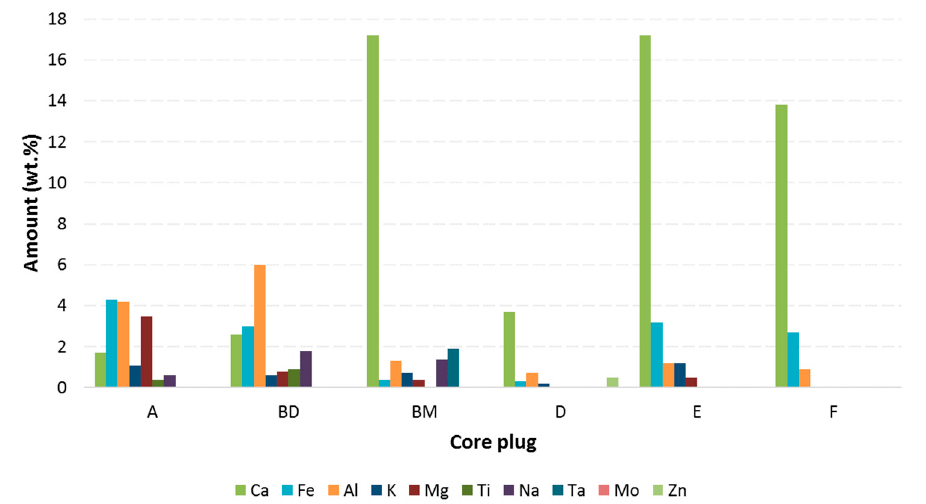
Figure 4. Semiquantitative elemental composition of studied core plugs obtained by SEM–EDS analysis. The amounts of oxygen, carbon, silicon, sulfur, phosphorus and chlorine are not shown.